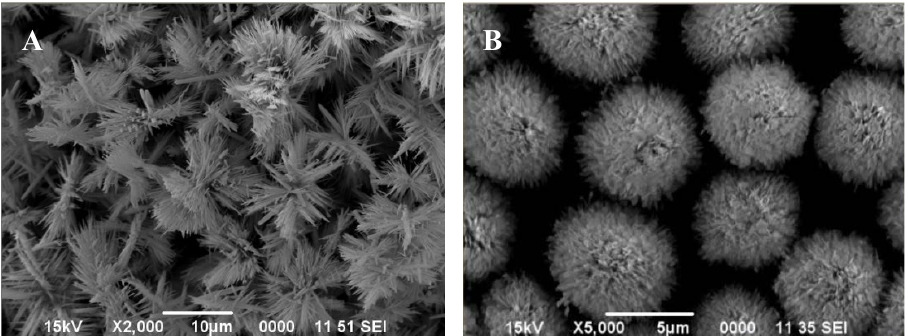
Figure 1. SEM images of the particles precipitated from an aqueous solution containing 0.4 mol/L urea and 0.035 mol/L zinc nitrate with 10 vol.% ethylene glycol, heated for 45 min. at: ( A ) 80 °C and ( B ) 95